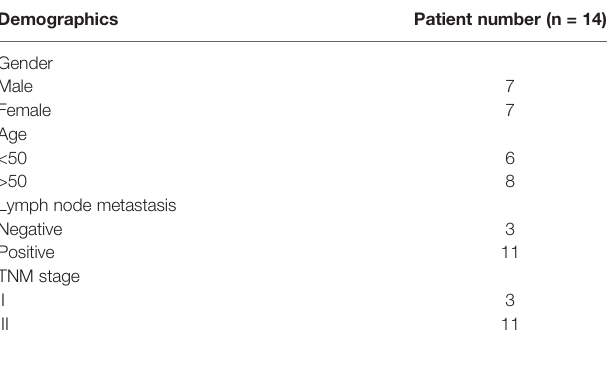
TABLE 1 | Clinical parameters of OSCC patients.